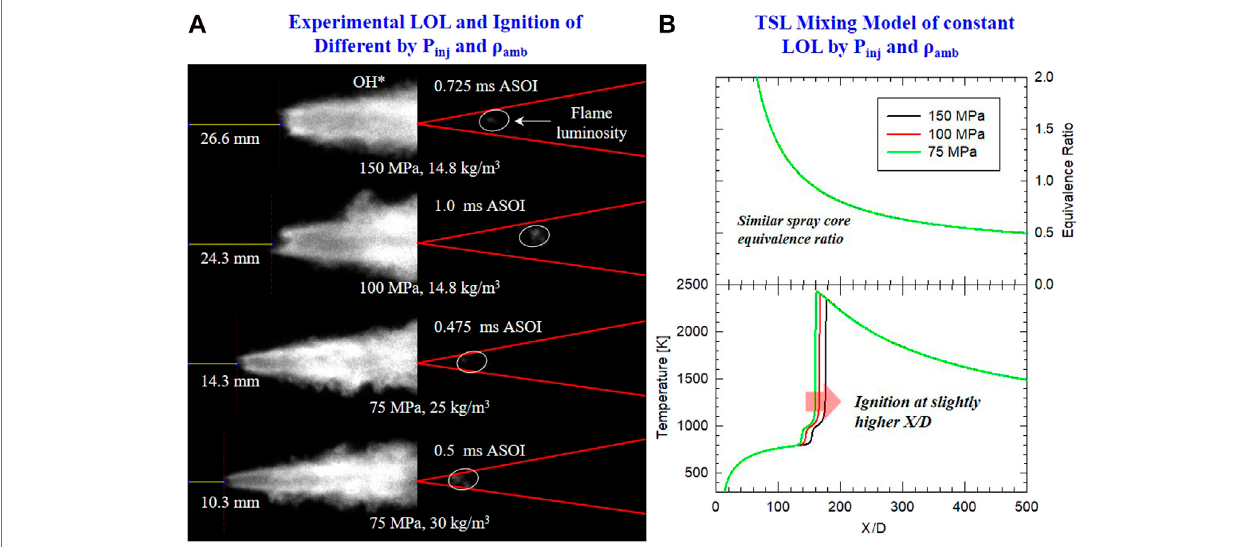
FIGURE9|(A) Time-averagedOH*chemiluminescence (left) and instantaneousHScombustion luminosity (right) at initialignition.ConditionsofP inj and ρ amb are given in each row. Other conditions are similar: T amb (cid:1) 900 K, 18% O 2 . (B) TSL simulation results ϕ (top) from lifted fl ame along spray axis, and spray core temperature (bottom) from mixing model. LOL is fi xed by different combinations of P inj and ρ amb . Other conditions are similar with T amb (cid:1) 900 K, 18% O 2